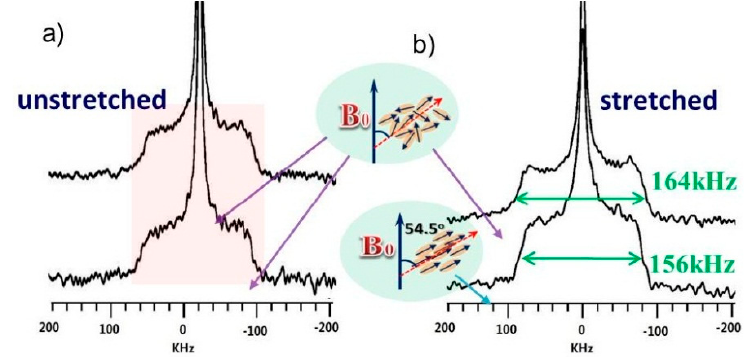
Figure 7. 2 H NMR spectra of unstretched ( a ) and stretched ( b ) CTS-N sample. The top spectra correspond to the randomly oriented powder samples, while the bottom spectra correspond to sample placed along the magic angle.